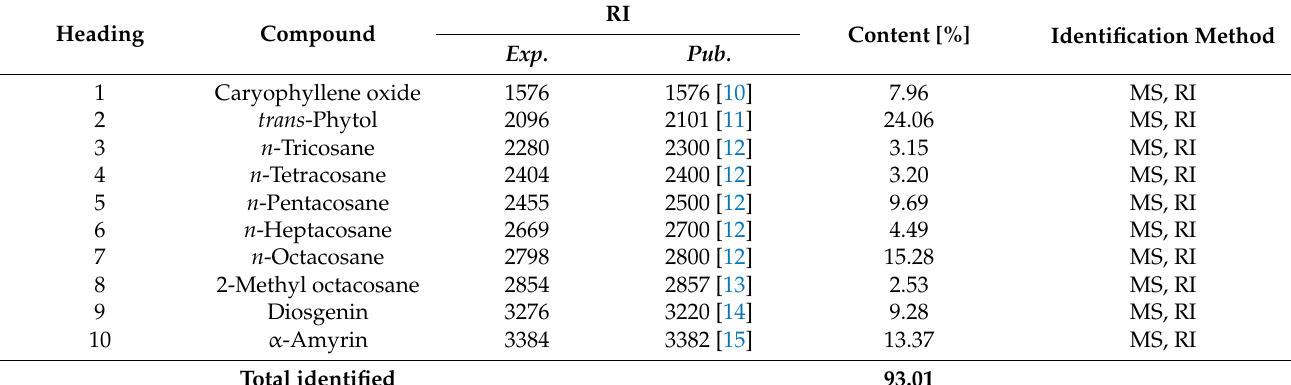
Table 2. Compounds identified from the n -hexane fraction of P. odorata leaves using GC/MS